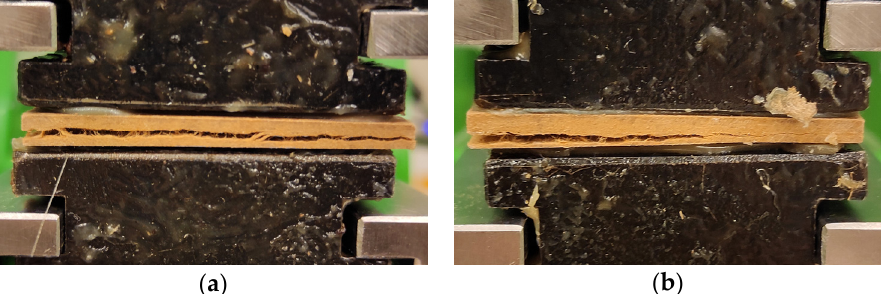
Figure 5. Two representative forms of damage after the IB test ( a ) in the core layer; ( b ) near-surface zone.